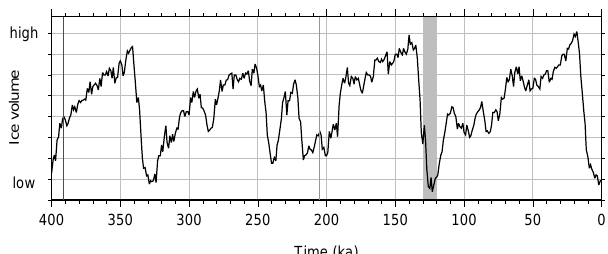
Fig. 7. Lisiecki (2005) stacked benthic δ 18 O record as proxy for global ice volume showing key times for spin-up run. For the gener- ation of the spin-up ensemble (see text for details), ice dynamics are only intermittently active from 391kyr (red) until 205kyr (green). For the ensemble proper, initialization starts at 205kyr. Approxi- mate period of the Eemian is highlighted in